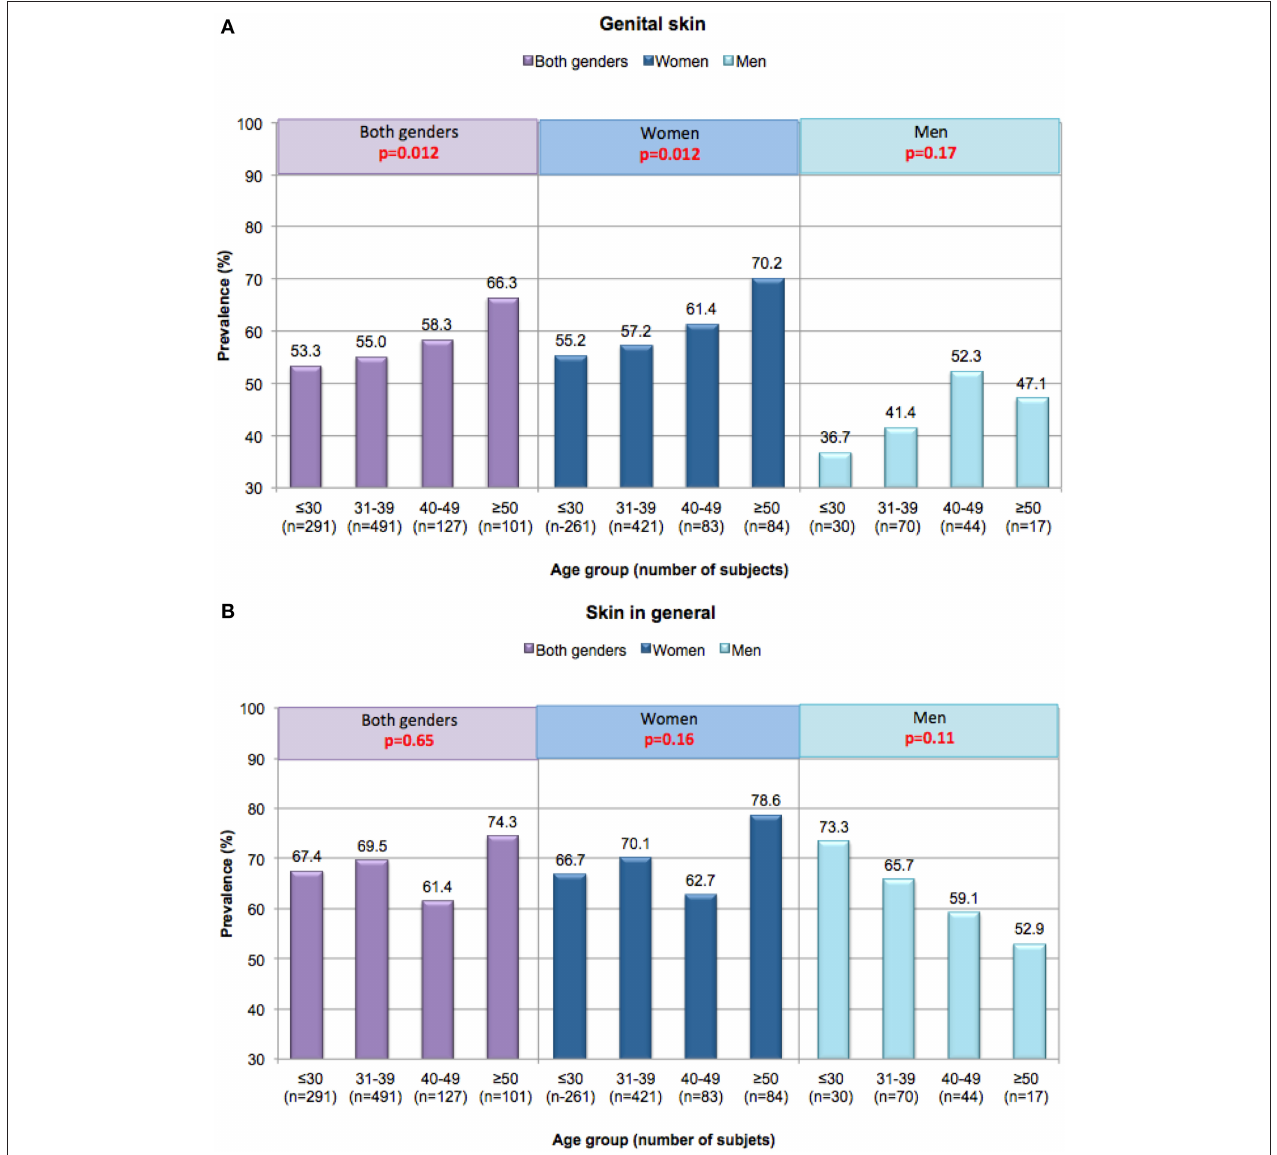
FIGURE 4 | Perceptions of sensitive skin among women and men in different age groups. Responses in the Cincinnati, Ohio study were evaluated based on age group. A Mantel-Haenszel chi-square analysis was conducted to determine if increasing age was associated with an increase in the prevalence of sensitive skin (any degree). (A) Sensitive genital skin, (B) sensitive skin in general. [Data adapted from Farage (16, 35)].